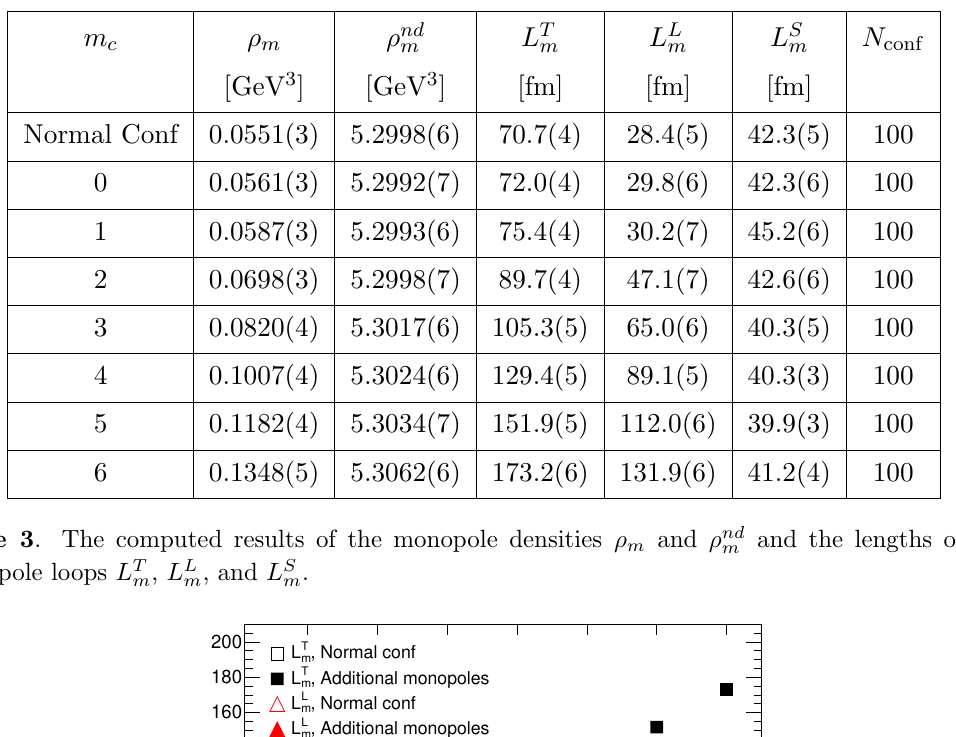
, L L , and L S . m m m